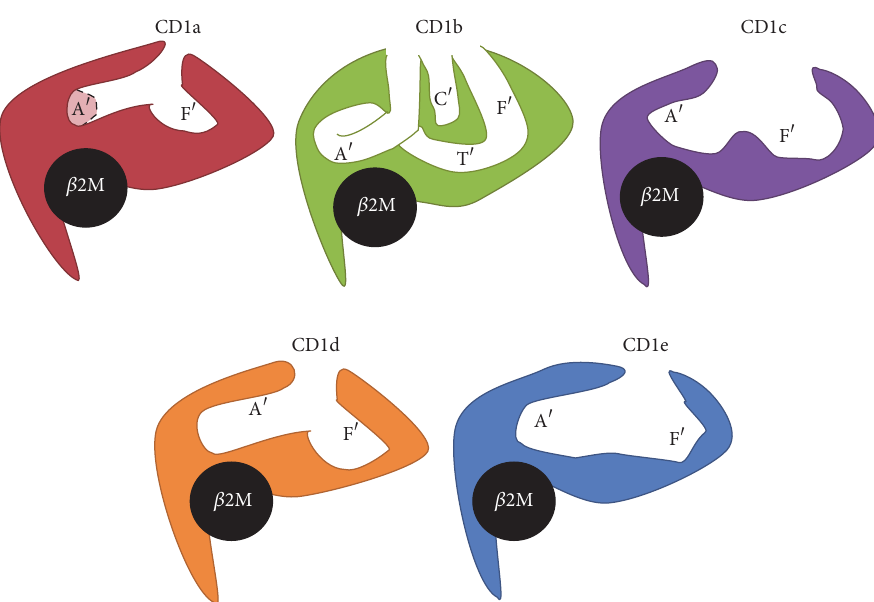
Figure 1: Schematic representation of the binding pockets from the different CD1 molecules (cross-sectional view). Dashed light colored area in CD1a represents the terminus of the A 󸀠 pocket. 𝛽 2M: 𝛽 2-microglobulin.